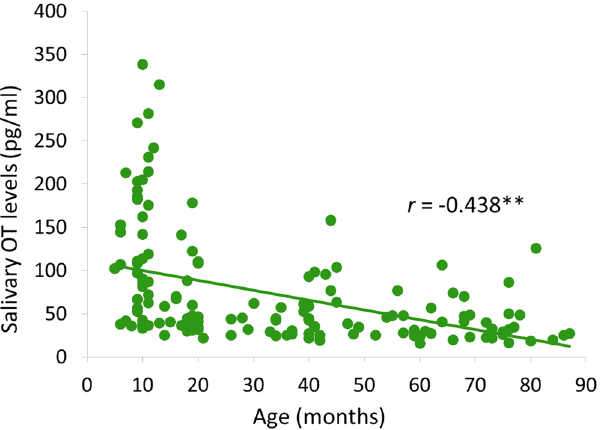
Figure 2. Relationship between age and salivary oxytocin (OT) levels. The vertical axis indicates salivary OT levels (pg/ml), whereas the horizontal axis indicates age. ** p <